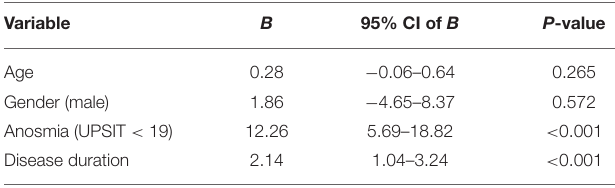
TABLE 6 | Multiple linear regression results for MDS-UPDRS total